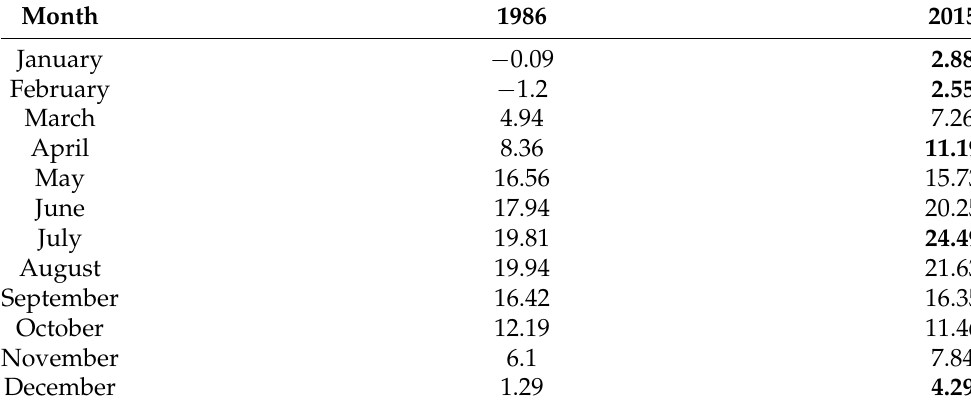
Figure 1. Average temperature in Lombardy over 12 months, recorded in 42 meteorologic stations. Plot a refers to the year 1986 and plot b to the year 2015. Table 1. Average temperature over 42 meteorologic stations of Lombardy in 1986 and 2015. The values highlighted in bold show the most relevant temperature increases in